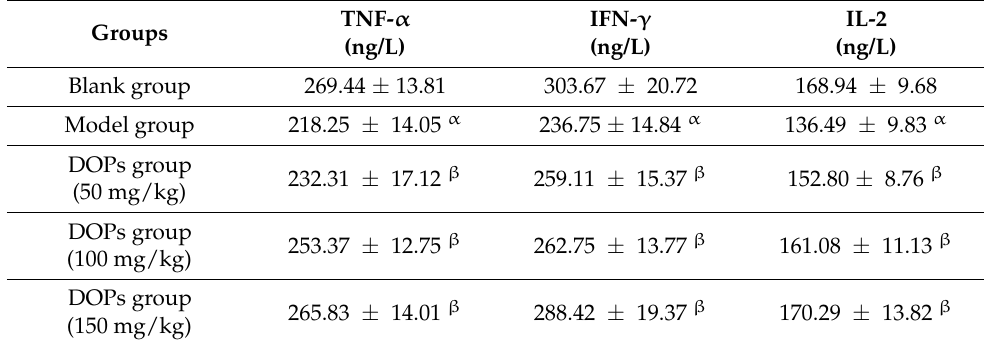
Table 2. Cytokines expressions levels of mice in each group.